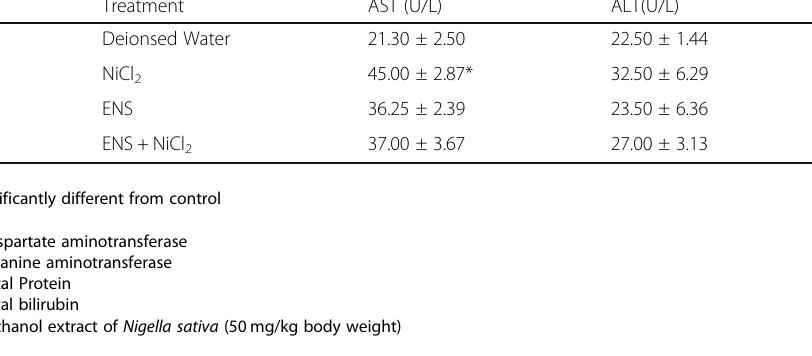
Table 2 Liver function markers in the serum of test and control animals